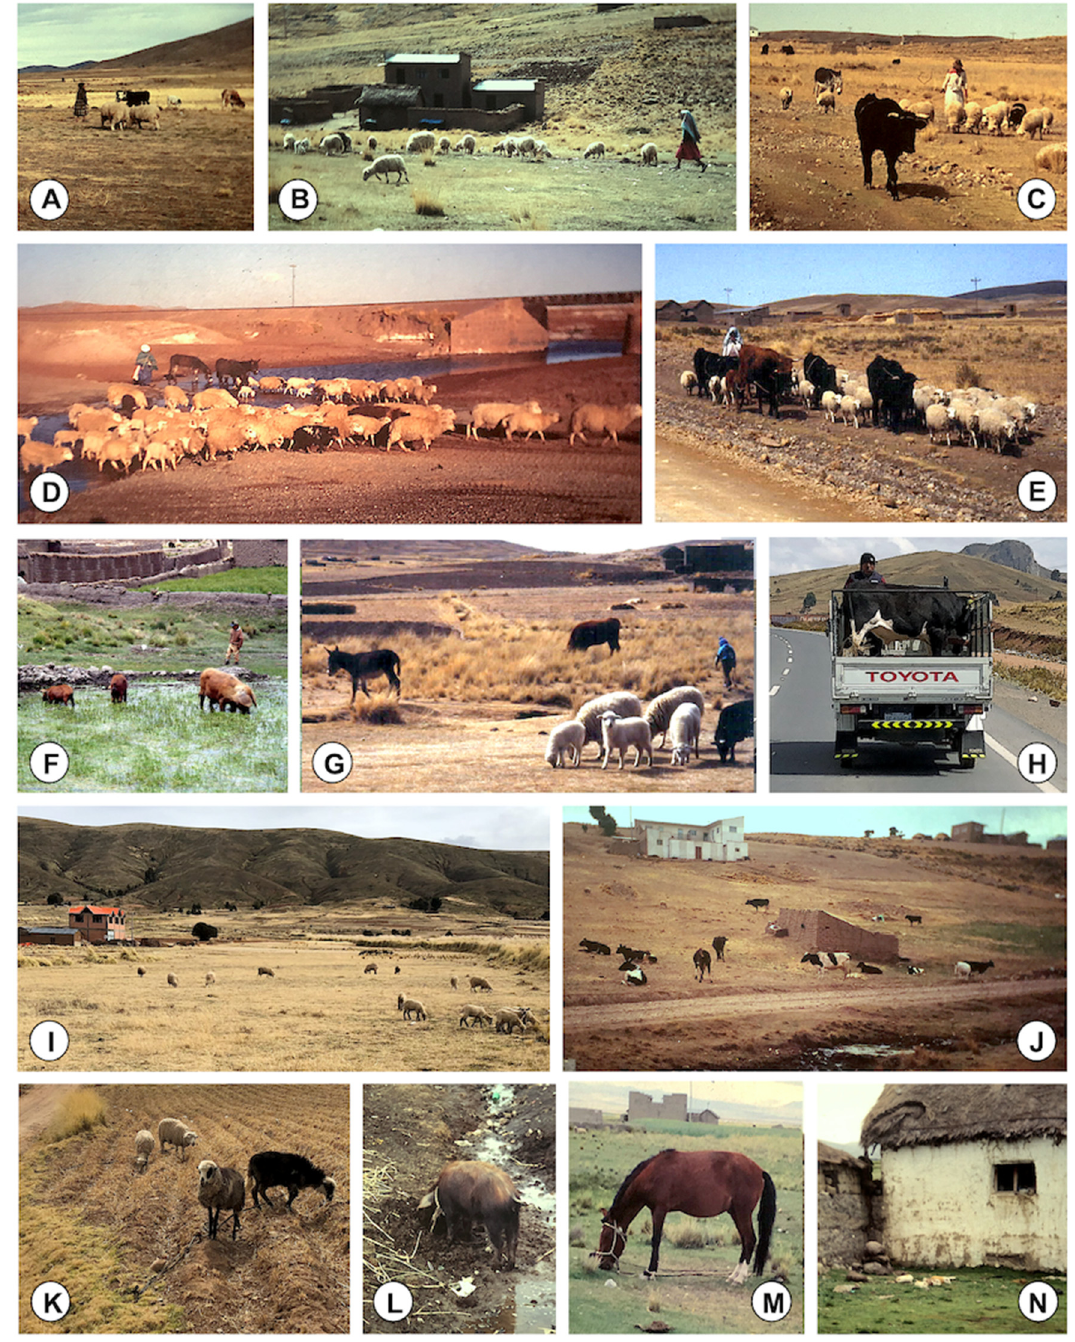
Figure 10. Livestock management: ( A – E ) Women are in charge of moving the herds of sheep, cattle, and donkeys, as in Achacachi ( A ), Huarina ( B , C , E ), and Capiri ( D ); ( F , G ) Children undertake responsibilities in livestock management starting at a very early age, as in Pucarani ( F ) and Copancara ( G ); ( H ) Transport of livestock is increasingly carried out with vehicles; ( I , J ) Freely running livestock is almost everywhere, as in Lacaya ( I ) and Kajchiri ( J ); ( K – M ) Stakes and rope are sometimes used to keep domestic animals in place, as for sheep in Santa Rosa ( K ), pigs in Batallas ( L ), and horses in Viacha ( M ); ( N ) Guinea pigs, locally known as “kuwis” or “cuyes”, are rarely kept by Aymaras in the Northern Altiplano, as in Peñas. Photographs S. Mas-Coma. F modified from Mas-Coma et al., Parasitology, 2018, 145,